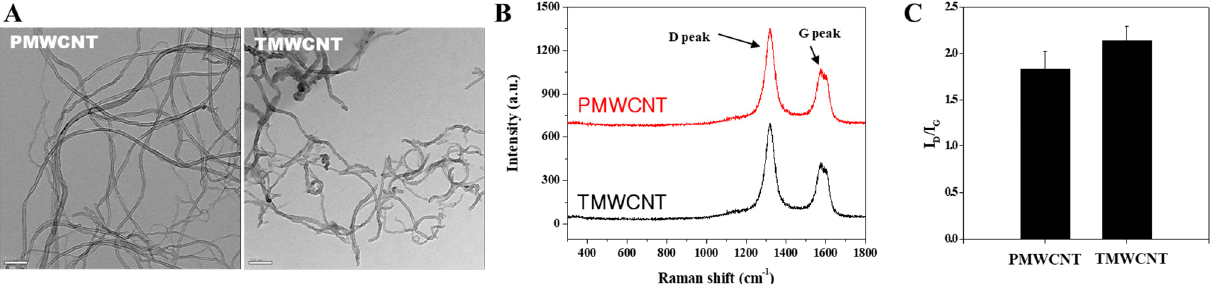
Figure 1. Characteristics of PMWCNTs and TMWCNTs. ( A ) TEM image of PMWCNTs (Left) and TMWCNTs (Right). ( B ) Raman spectra of PMWCNTs (Red) and TMWCNTs (Black). ( C ) Intensity ratio of Raman D peak and G peak. TMWCNTs show higher I D /I G ratio than that of PMWCNTs. Table 1. The differences in metal catalyst contents between PMWCNTs and TMWCNTs. PMWCNT (ppm)